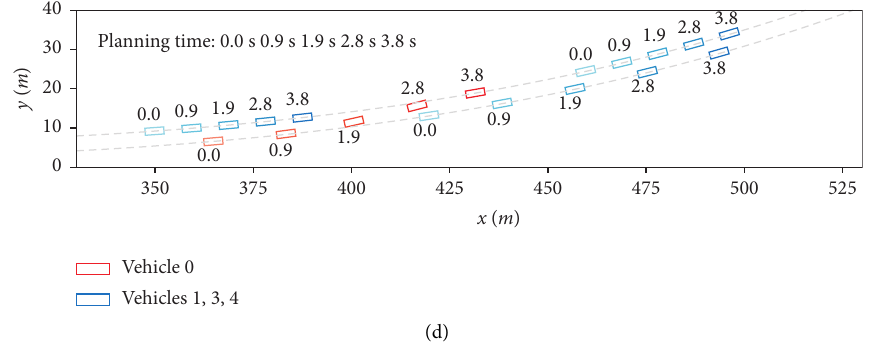
Figure 10: Time-related dynamics between vehicles 0, 1, 3, and 4 under scenarios 1, 2, 3, and 4. (a) Time-related trajectory planning results for scenario 1. (b) Time-related trajectory planning results for scenario 2. (c) Time-related trajectory planning results for scenario 3. (d) Time-related trajectory planning results for scenario